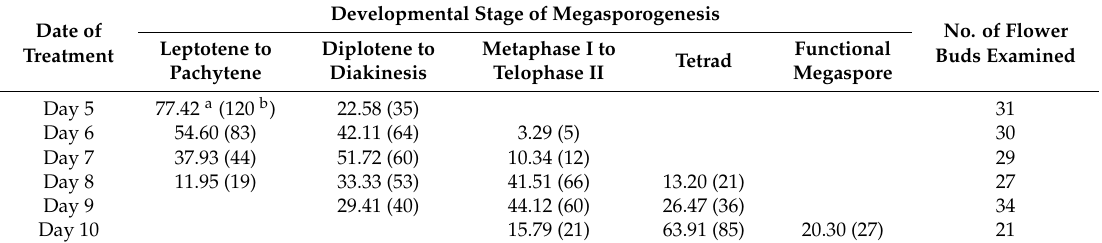
Table 4. Megasporogenesis stages on different days for colchicine treatments in Eucalyptus urophylla